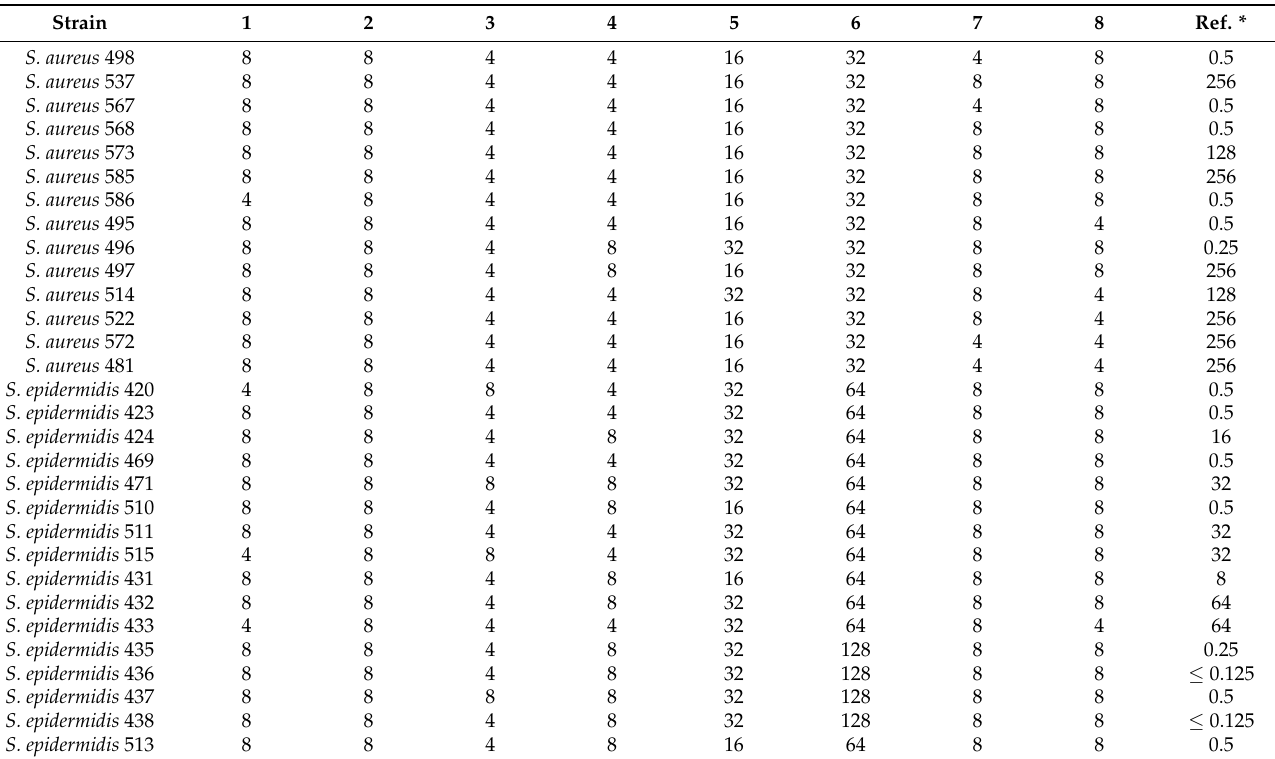
Table 5. In vitro activity of complexes 1 – 8 against hospital methicillin-resistant strains of Staphylococcus aureus (MRSA) and Staphylococcus epidermidis (MRSE)—minimal inhibitory concentrations (MIC, µ